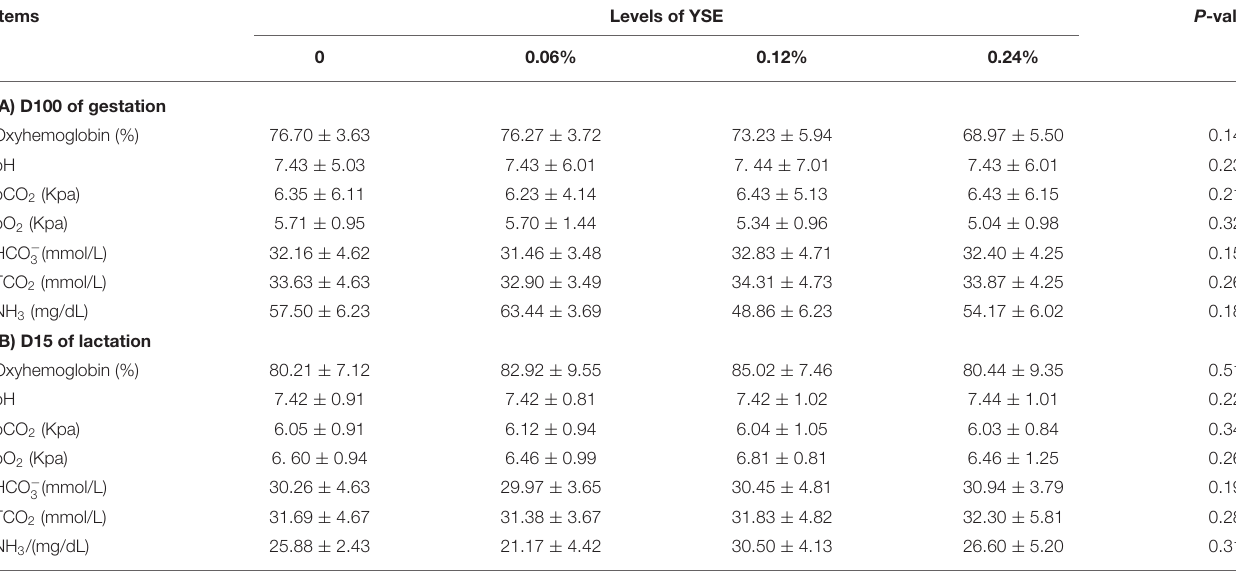
TABLE 6 | Effect of dietary YSE to blood gas in gestating and lactating sow. Items Levels of YSE P -value